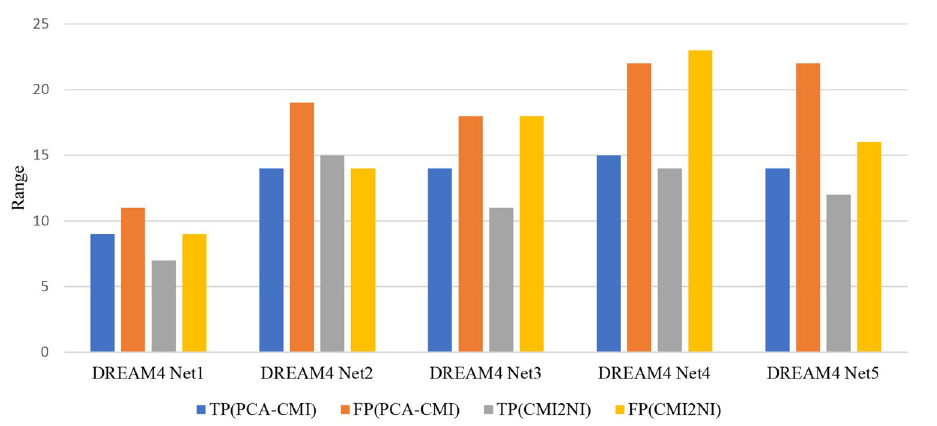
Figure 4. Range of the variation TP and FP values for 1000 randomly-generated permutation for DREAM3 and DREAM4 datasets resulted by PCA-CMI and CMI2NI